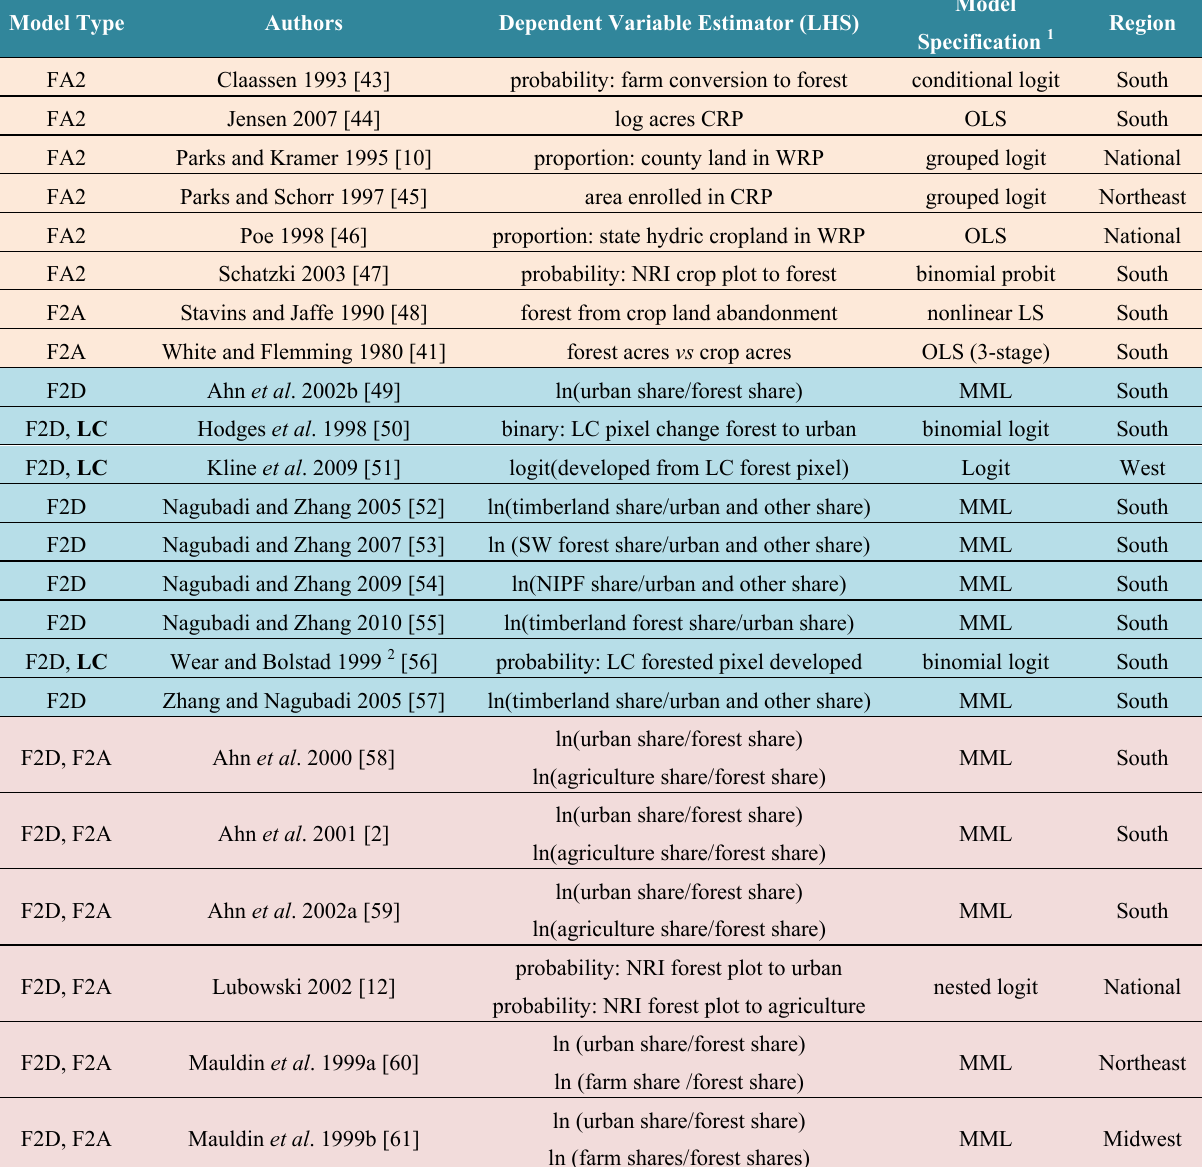
Table 2. Characteristics of 47 econometric studies used in this meta-analysis by forest LULC change models, authors, dependent variable, and model specification. The LULC change model types studied were forest to agriculture (F2A, 21 models), forest to development (F2D, 21 models), undeveloped to developed (U2D, 10 models), and forest to non-forest (F2NF, 12 models). (LC) identifies the 6 land cover change models, all others were land use change